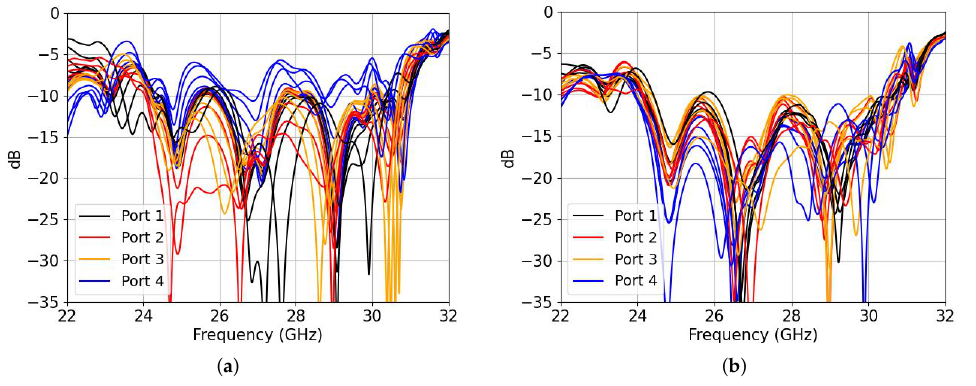
Figure 7. Simulated input reflection coefficients for each port: ( a ) without nails; ( b ) with nails. There are 6 traces per port relating to the progressive phase from 0 ◦ to 140 ◦ at 26.5 GHz.